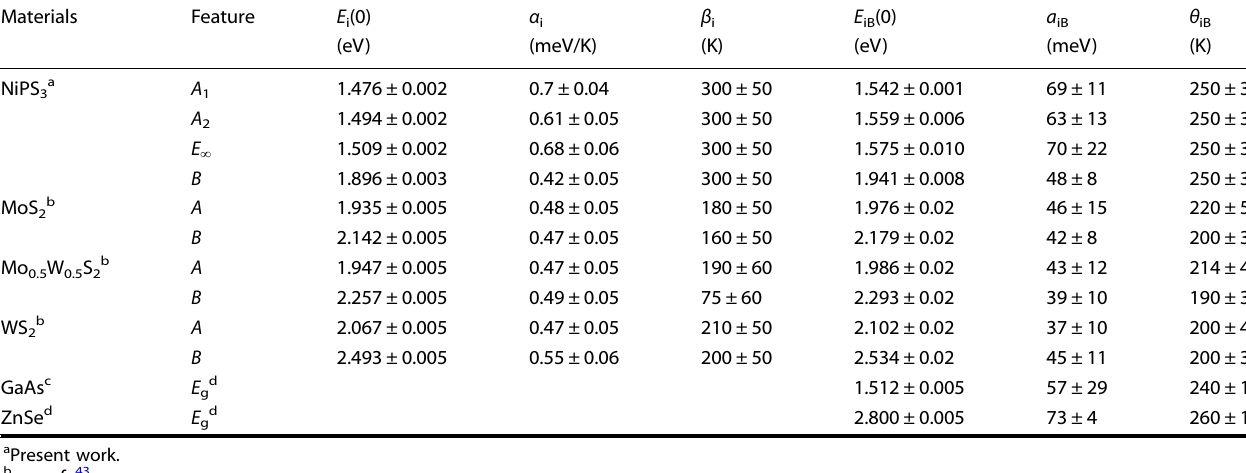
Table 1. Values of the Varshni and Bose – Einstein type fi tting parameters that describe the temperature dependences of the excitonic transition energies of the A 1 , A 2 , E ∞ , and B in the few-layer NiPS 3 together with those previously obtained for MoS 2 , WS 2 , Mo 0.5 W 0.5 S 2 , GaAs, and ZnSe.